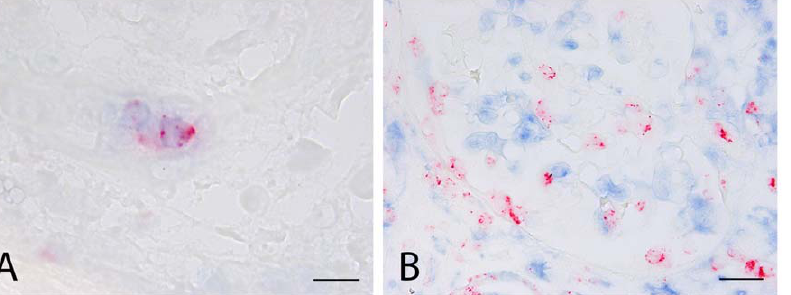
Figure 3. A: Immunohistochemical doublestaining of a renal allograft specimen with Granzyme B (red) and CD57 (blue), illustrating a Granzyme B positive NK cell. Bar=10 m m. B: Doublestaining of Granzyme B (red) with CD68 (blue). Note that macrophages do not express Granzyme B. Bar=25 m m.